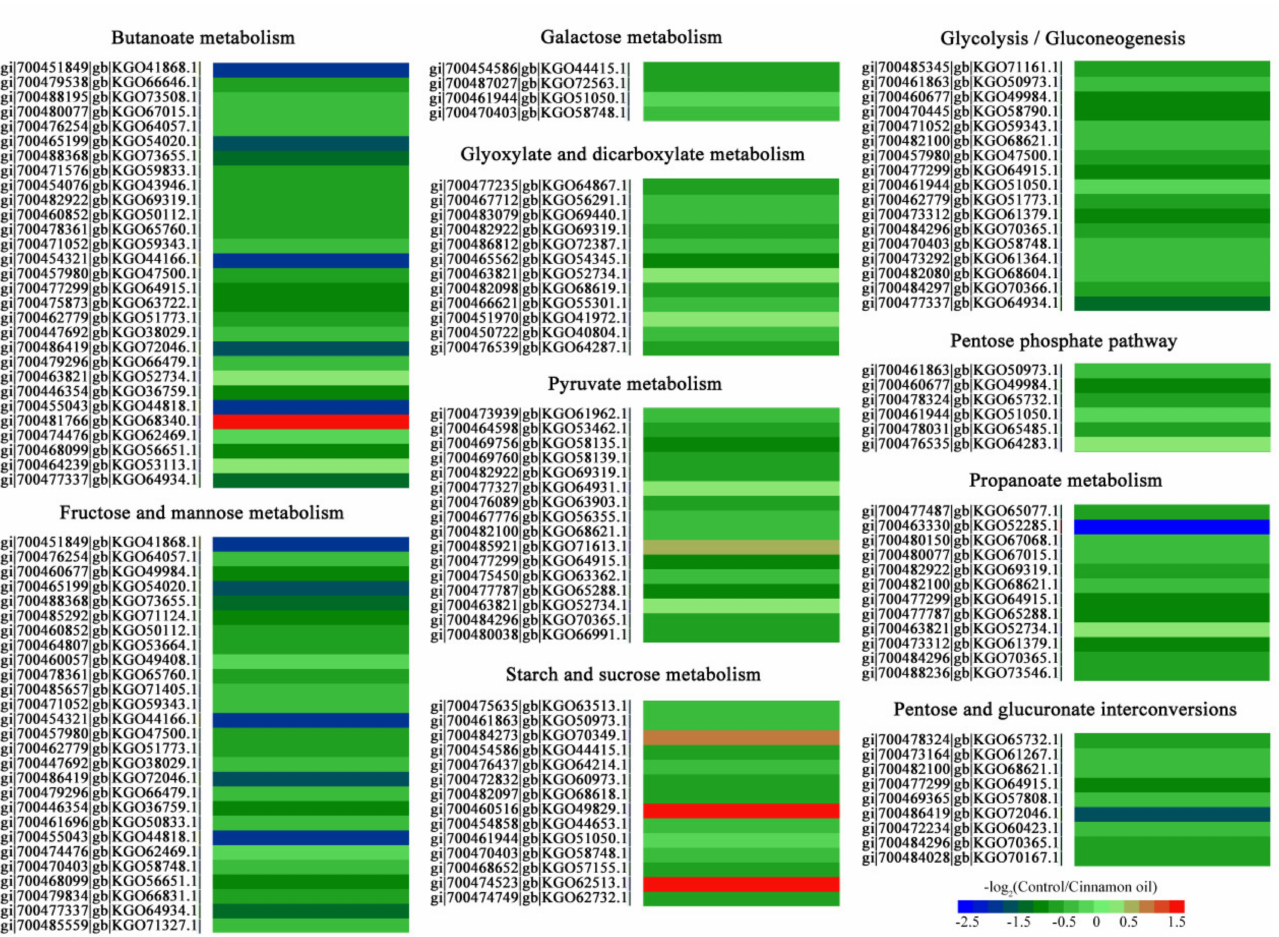
Figure 5. Heatmap of expression changes of DEGs involved in the carbohydrate metabolic process in P. expansum spores under 0.25 mg L − 1 cinnamon oil stress after 6 h of culture. Each row represents a DEP. The annotation and involved metabolic pathway of each DEP are listed. Red to blue in the color code indicates up- to down-regulated expression of the